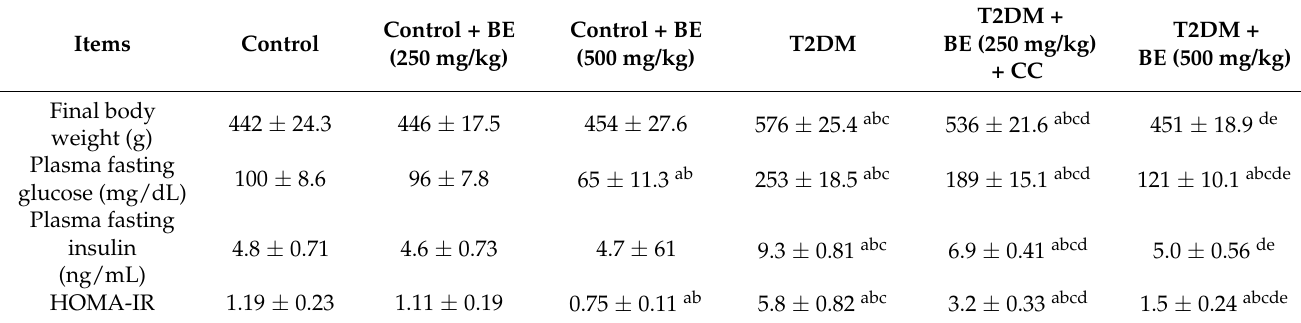
Table 2. Average final body weights (A), levels of fasting glucose (B) and insulin (C), and values of HOMA-IR (D) in all groups of